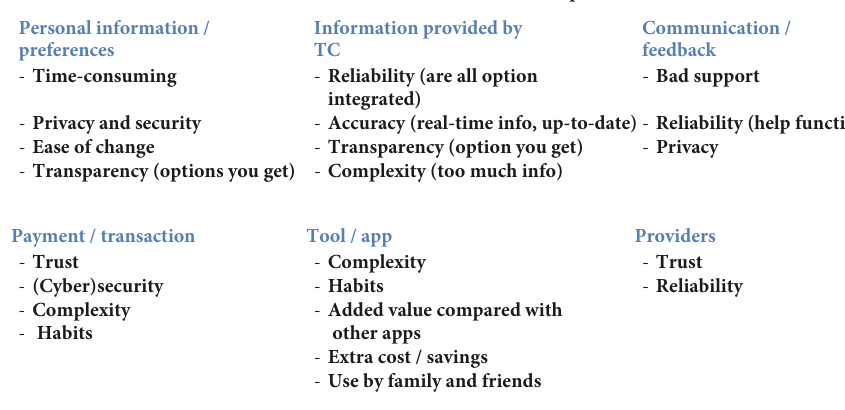
Figure 3: Barriers for the use of the